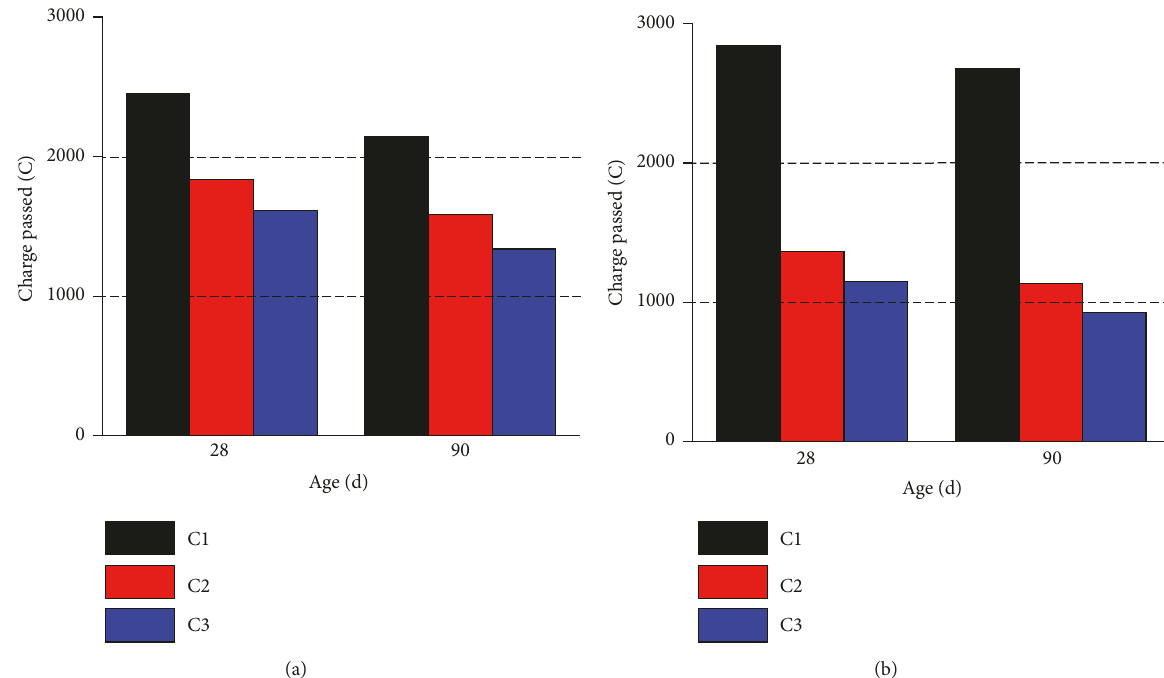
Figure 7: (a)Chloride ion permeability for the concrete for standard curing. (b) Chloride ion permeability for the concrete for temperature match